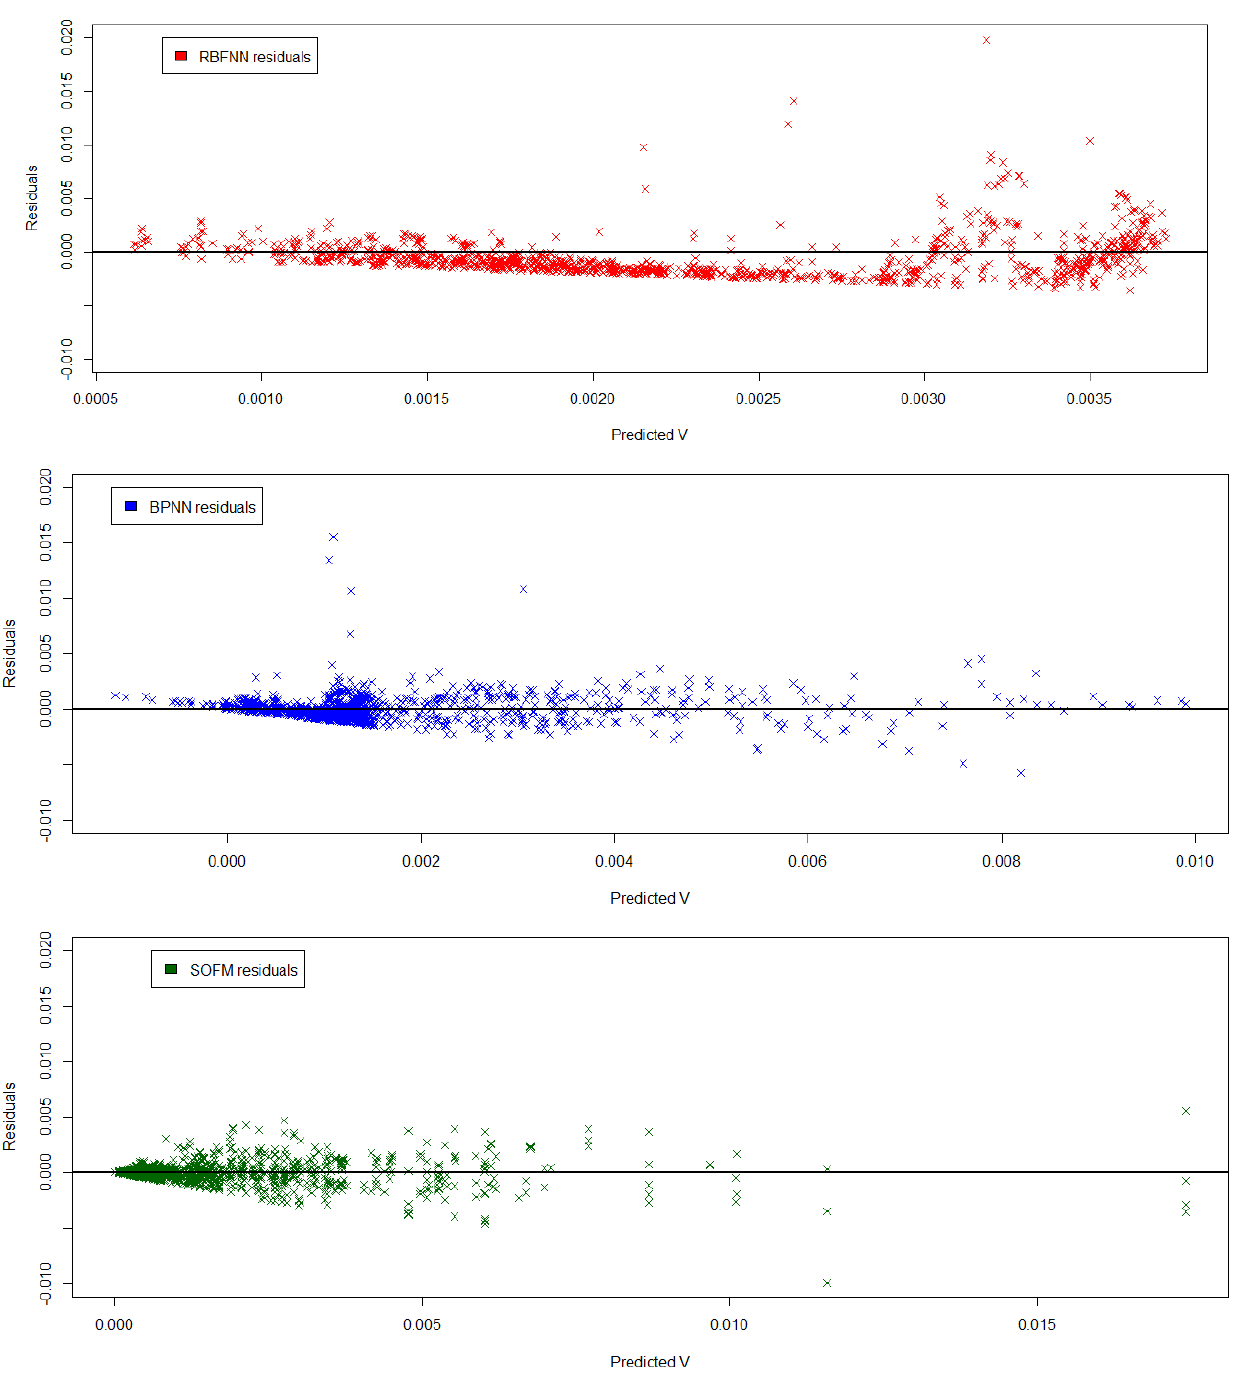
Figure 11. Residual plots of the three ANN models (RBFNN, BPNN,